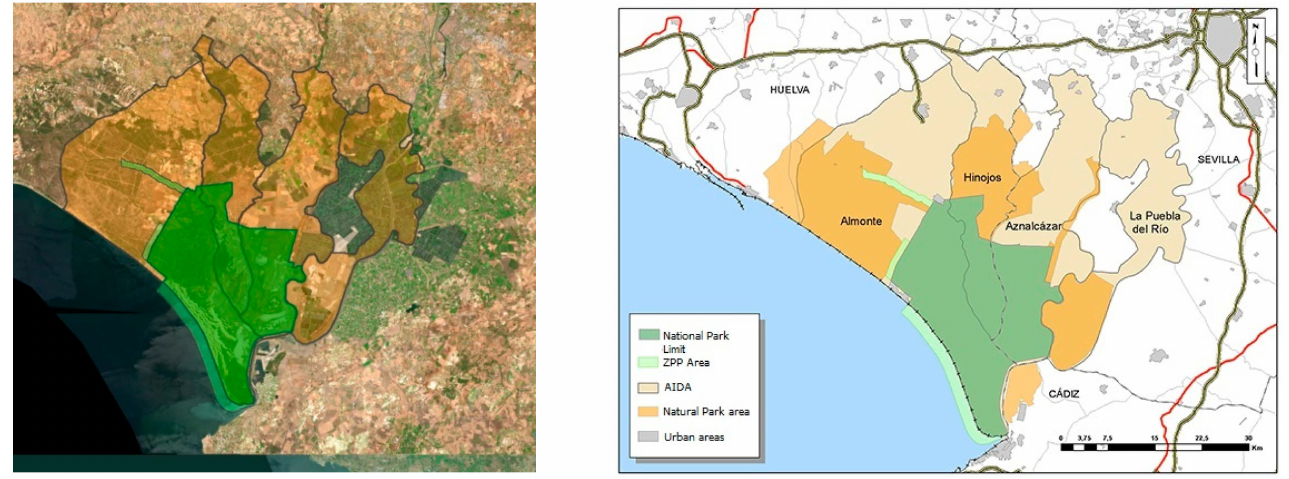
Figure 8. Area of influence of diffuse anthropization in the Tablas de Daimiel National Park.